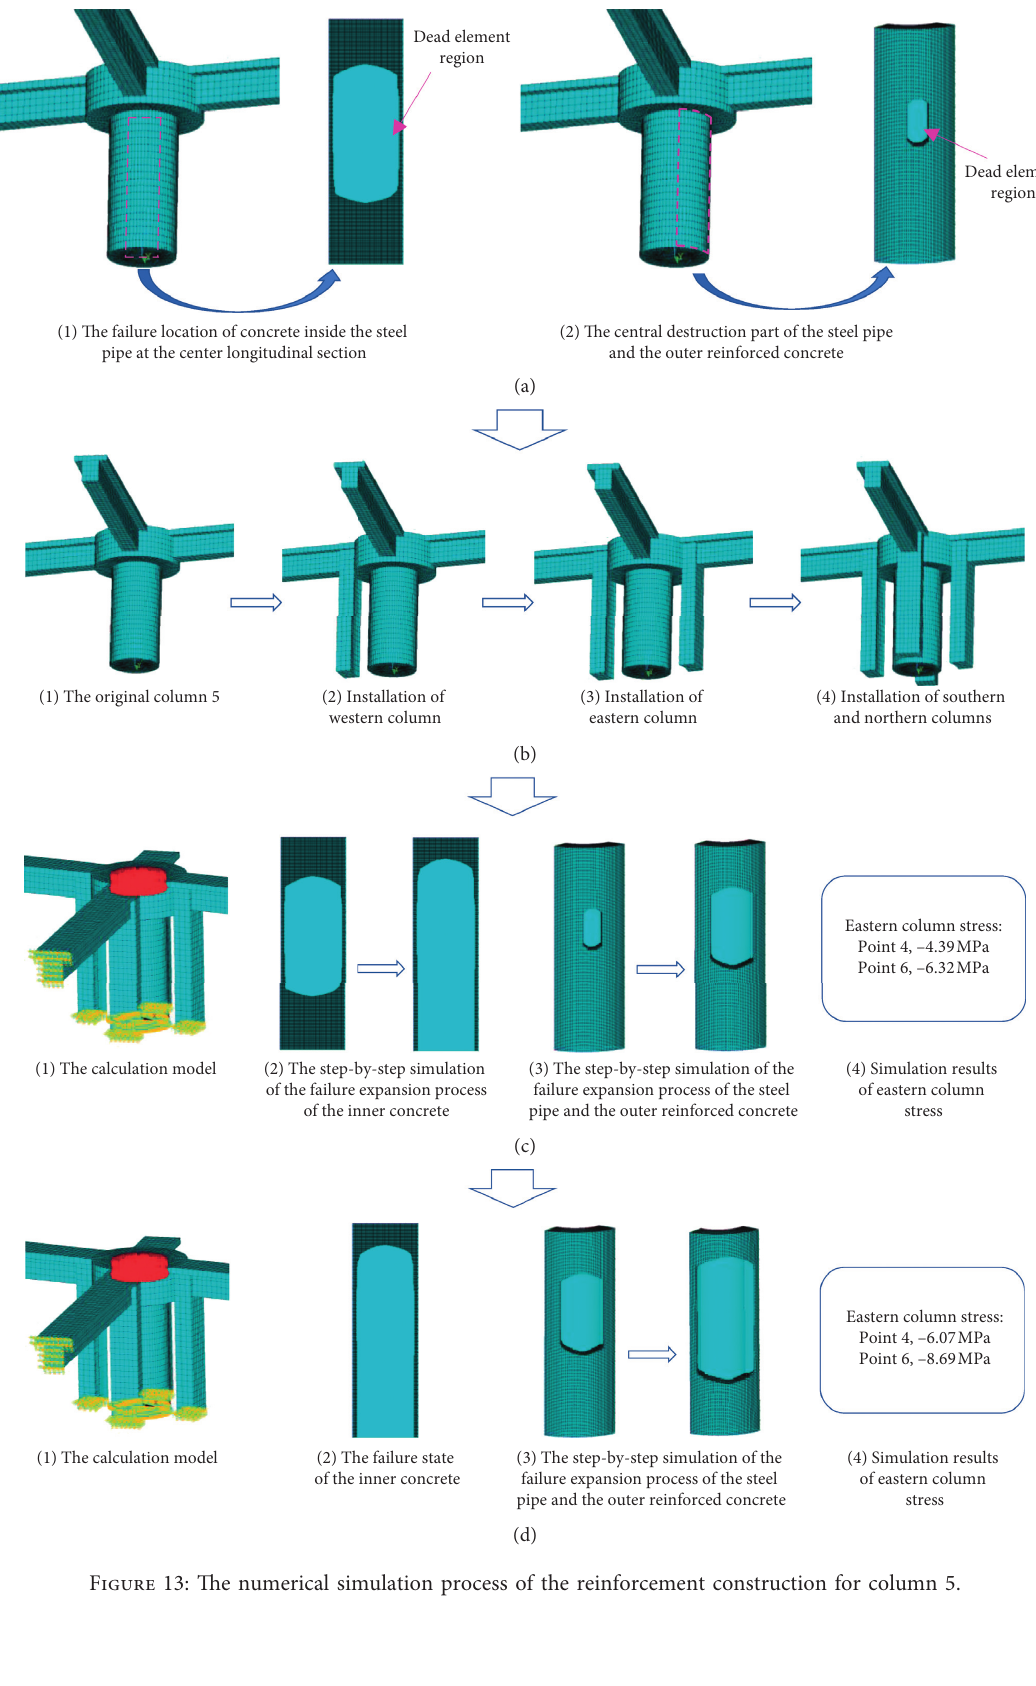
Figure 13: The numerical simulation process of the reinforcement construction for column